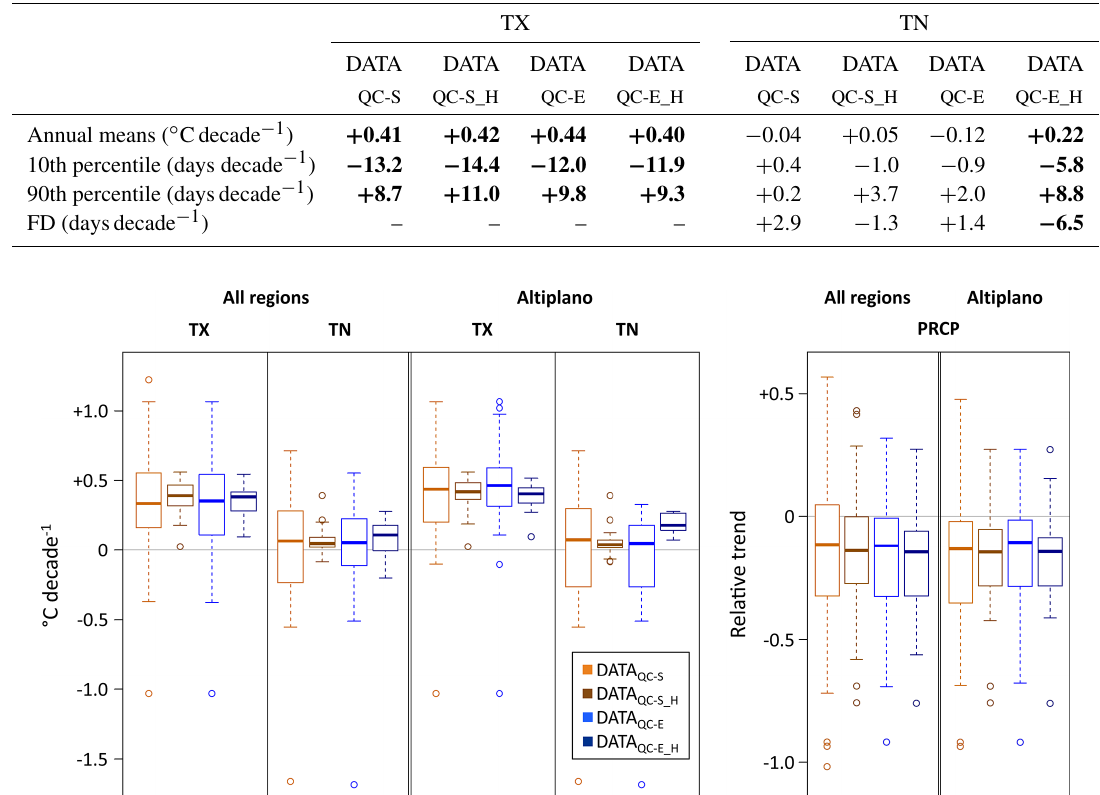
Figure 8. Trends of individual station records for maximum temperature (TX), minimum temperature (TN), and precipitation (PRCP) in the period 1981 to 2010. Trend box plots for the complete study area and for the Altiplano ( ≥ 3500ma . s . l . ) are shown. Colours indicate the different datasets that are unhomogenized and quality controlled with the standard approach (DATA QC-S ), homogenized and quality controlled with the standard approach (DATA QC-S_H ), unhomogenized and quality controlled with the enhanced approach (DATA QC-E ), and homogenized and quality controlled with the enhanced approach (DATA QC-E_H ). For temperature, trends are specified in ◦ C per decade. For PRCP, relative trends from 1980 to 2010 are shown (see the caption of Fig. 7 for details). The box plots show the median, the 25th and 75th percentile, and the 1 . 5 × IQR